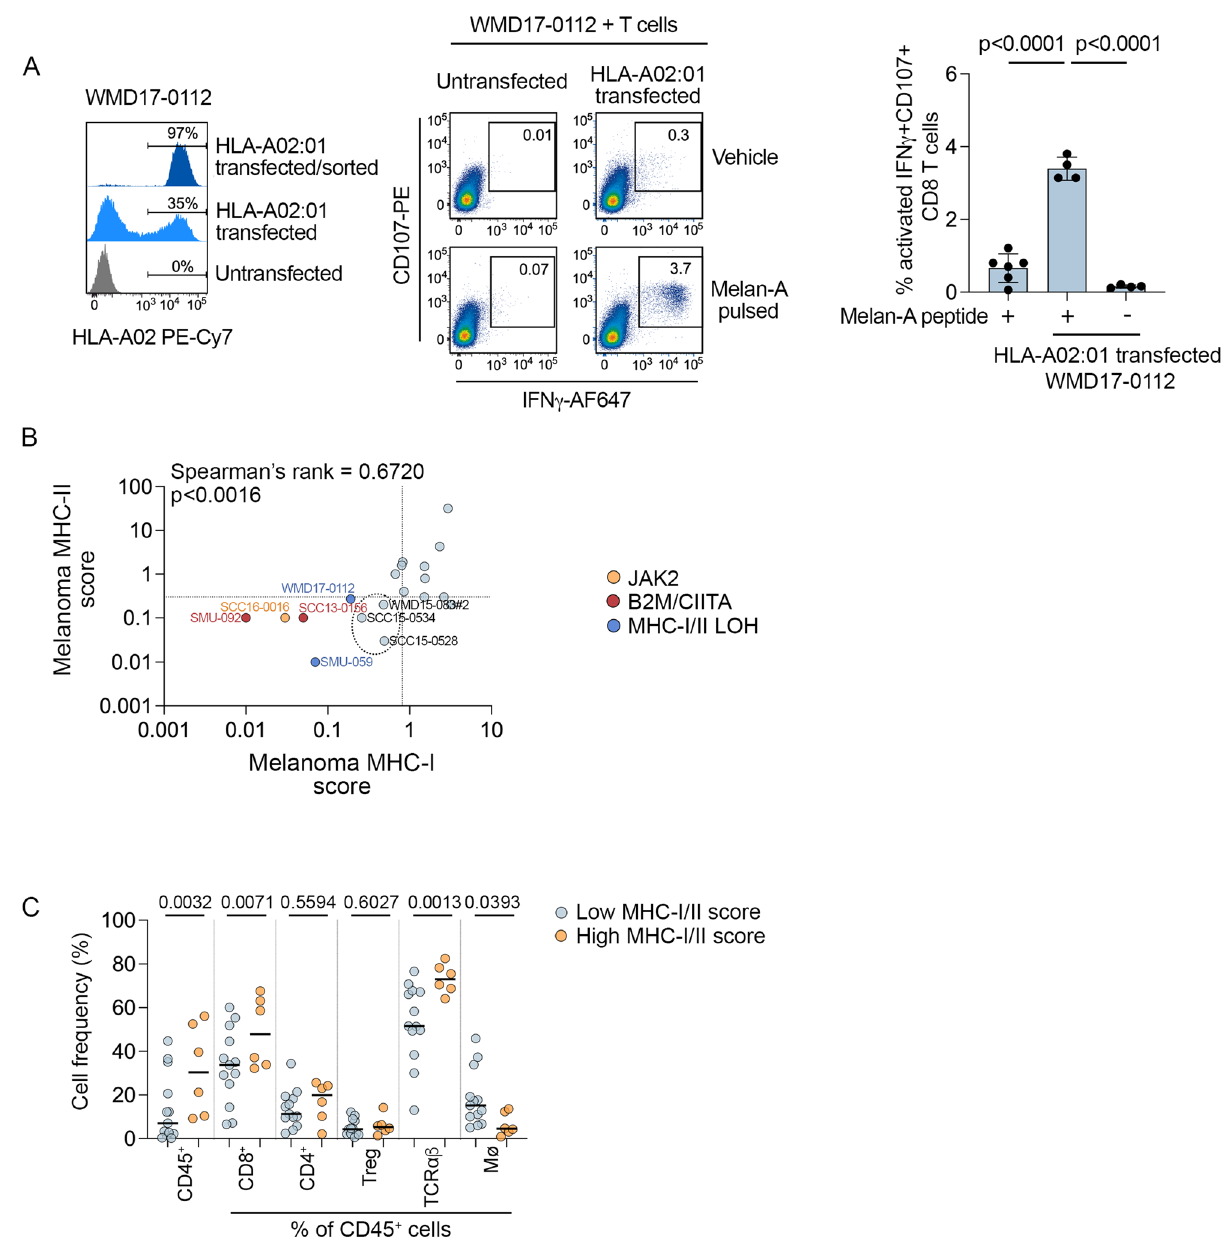
Fig. 7 | Loss of MHC antigen presentation molecules. A Representative histo- gramsshowingexpressionofHLA-A02:01intheWMD17-0012PD1PROGmelanoma cells (HLA-A02:01 LOH, Melan-A null ). Untransfected cells are compared to cells transfected with HLA-A02:01 pre and post fl ow sorting (left panel). Reactivity of allogenic HLA-A02:01 matched CD8 + T cells (CD107 + /IFN γ + ) to untransfected or HLA-A02:01-transfected WMD17-0112 cells pulsed with 10 µ g/ml Melan-A peptide (AAGIGILTV) or vehicle control, 1.5h before co-culture (middle panel). Bar graph shows percentage (individual values and mean±sd) of reactive CD107 + IFN γ + CD8 + T cells co-cultured with untransfected/Melan-A pulsed (+) WMD-0112 cells ( n =6 biological replicates) and HLA-A02:01-transfected Melan-A pulsed (+) or HLA- A02:01 vehicle treated ( − ) WMD17-0112 cells ( n =4 biological experiments). Data compared using one-way ANOVA with Tukey ’ s multiple comparison test, adjusted p -values are shown. B Scatterplot showing correlation of MHC-II and MHC-I